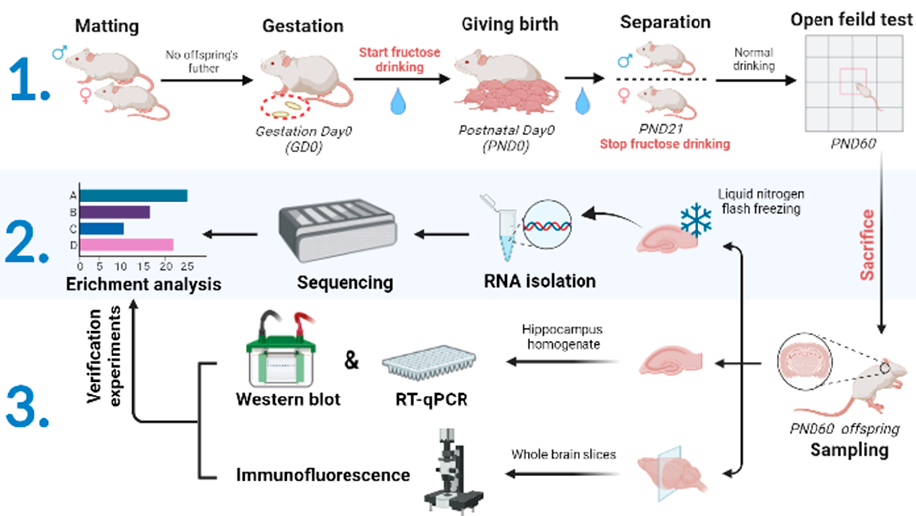
Figure 8. Animal model construction and experiment pipeline. The first step was the animal mod- eling process, the second was the sequencing analysis process, and the third was the experimental verification